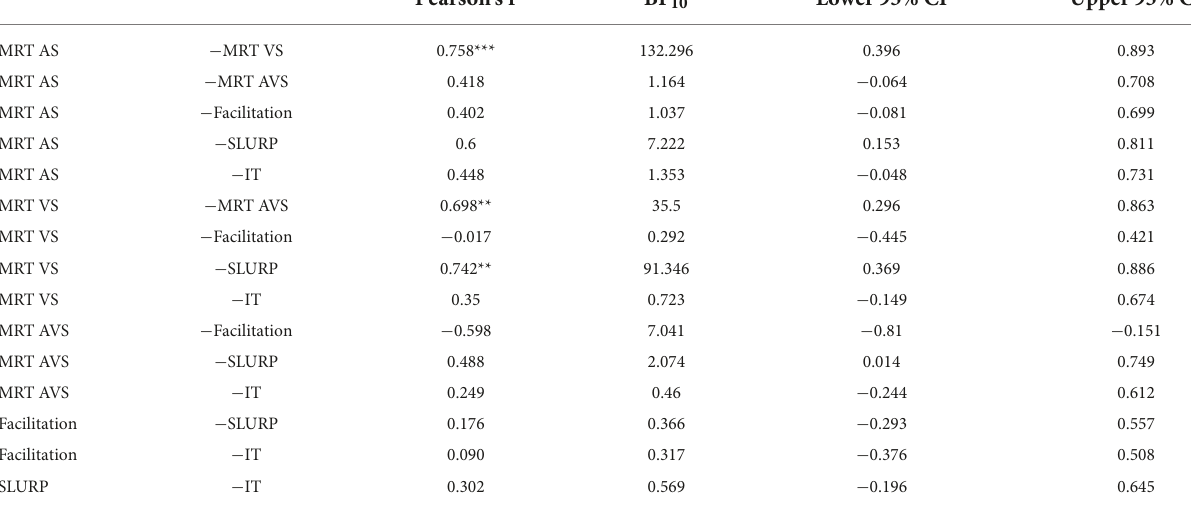
TABLE 6 Bayesian Pearson Correlations, 9 − 10